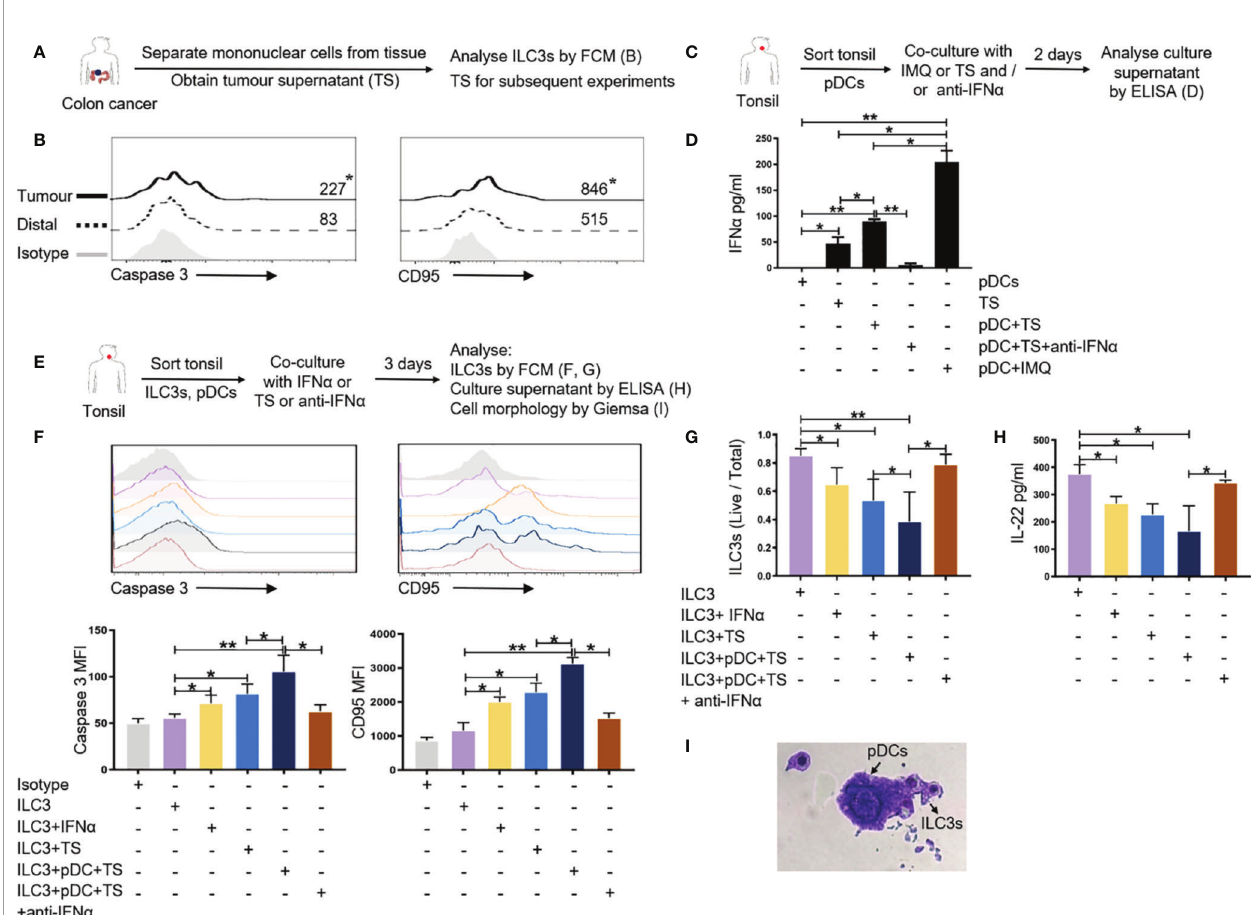
FIGURE 6 | pDCs can affect the survival of ILC3s in the tumor-like microenvironment. (A, B) MNCs from tumor and distal regions from three patients with colon cancer were prepared. Flow cytometric analysis was performed for the expression of apoptosis-related genes caspase 3 and CD95 on ILC3s in the tumor and distal tissue control groups. (C, D) pDCs from normal tonsil tissue were prepared. TS was added to the pDC culture system and the culture supernatant was collected to detect the secretion of cytokine IFN-a from pDCs by ELISA; IMQ was used as a positive control; anti-IFN a was used to neutralize IFN-a. TS is from tumors of three patients with colon cancer. (E – I) ILC3s and pDCs from normal tonsil tissue were prepared. TS, IFN-a, and anti-IFN a was added to the culture system of ILC3s and pDCs. Flow cytometric analysis of the expression of apoptosis-related genes (F) and the survival rate of ILC3s (G) are shown. ELISA was used to detect the secretion of IL-22 in co-culture supernatant (H) . Giemsa staining was used to detect the morphology of ILC3s and pDCs (I) (magni fi cation, 50×). Each experiment was repeated three times. A paired t -test and Spearman test were used for statistical comparisons. * P < 0.05; ** P <